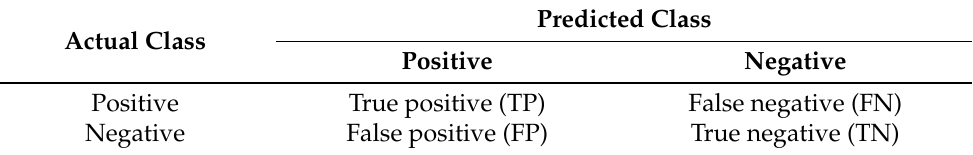
Table 5. Confusion